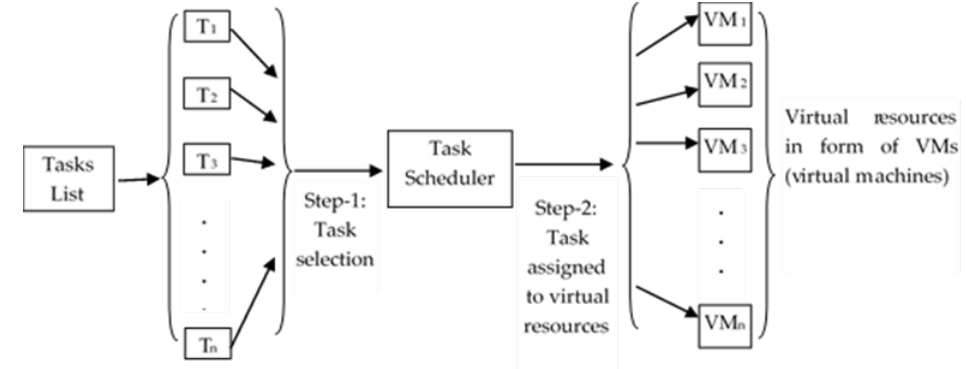
Figure 2. Task scheduling in a cloud-based framework.